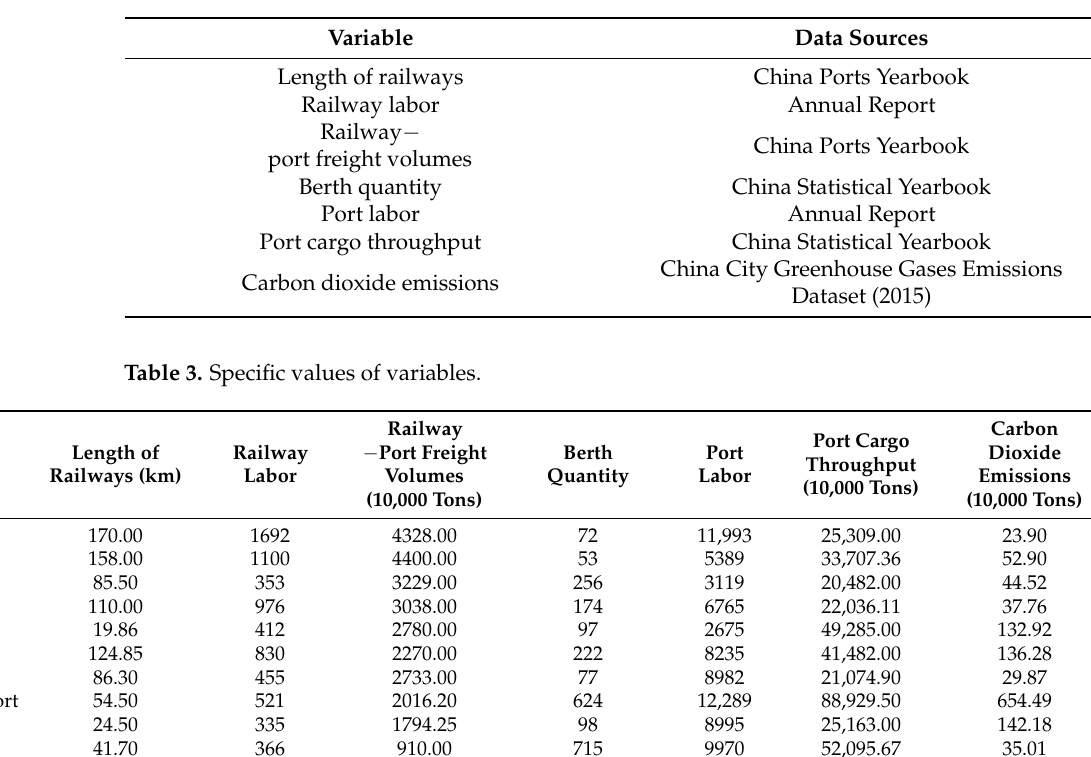
Table 2. Data sources.